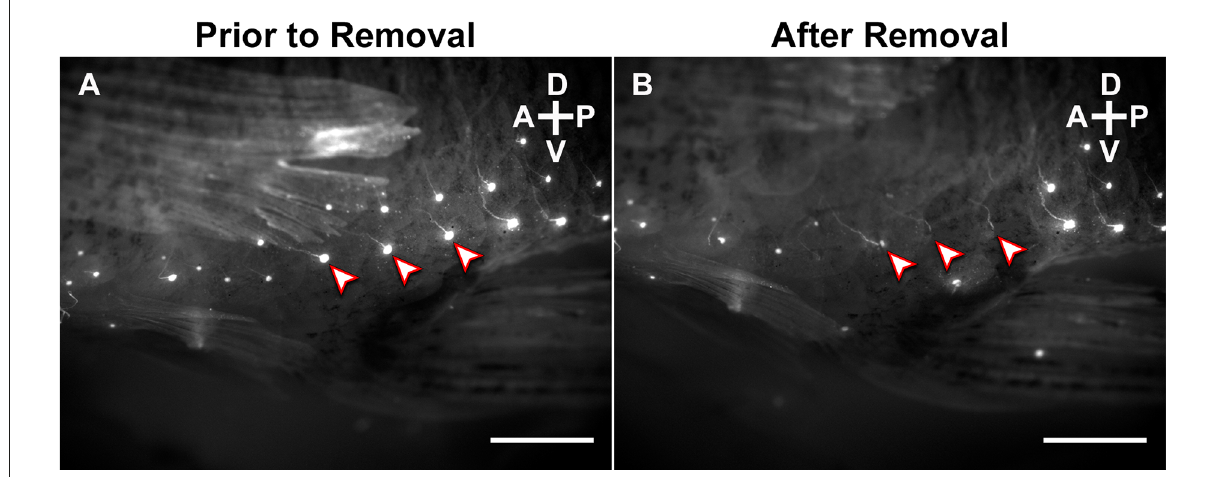
FIGURE3 Lateral view of the base of the gonopodium of an adult male mosquitofish (A) before and (B) after removal of superficial neuromasts. Superficial neuromasts were stained with 10 µ M solution of 4-Di-2-asp overnight at 20 ◦ C in a darkened room before 3D kinematics recording. Arrowheads highlight three representative neuromasts that were carefully removed using microsurgical forceps, preserving each superficial neuromast’s corresponding ascending nerve fibers. Scale bars = 20 µ m. A, anterior; P, posterior; D, dorsal; V,